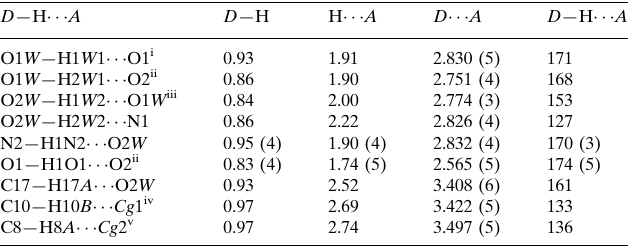
Hydrogen-bond geometry (A˚ , (cid:2) ). Cg 1 and Cg 2 are the centroids of the C1–C6 and C12–C17 benzene rings,